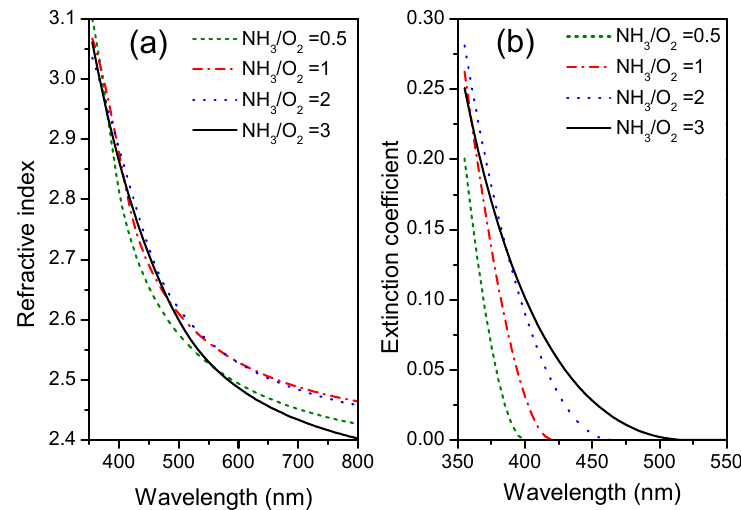
Figure 10. Refractive indices ( a ) and extinction coefficients ( b ) of the films as functions of NH 3 /O 2 gas ratio and wavelength.